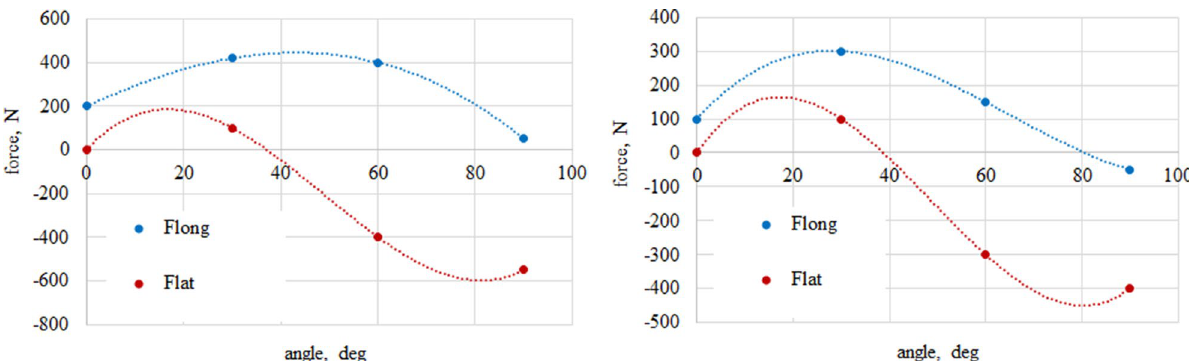
Figure 14. Values of calculated longitudinal and lateral forces depending of the slip (attack) angle—compacted